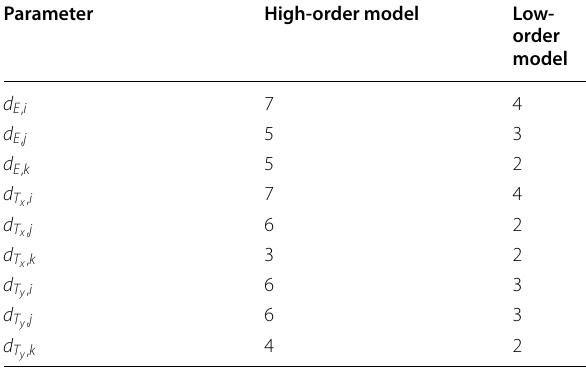
Table 6 Polynomial degrees for high-order and low-order TII level 1b transfer functions Parameter